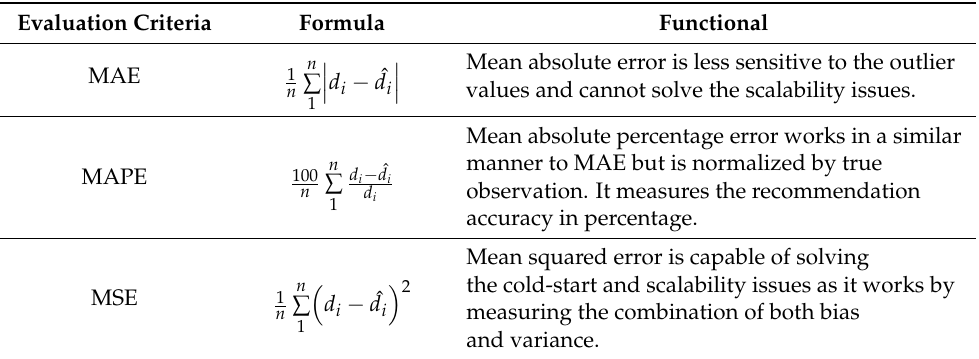
Table 8. Formulas of MAE, MAPE, and MSE evaluation